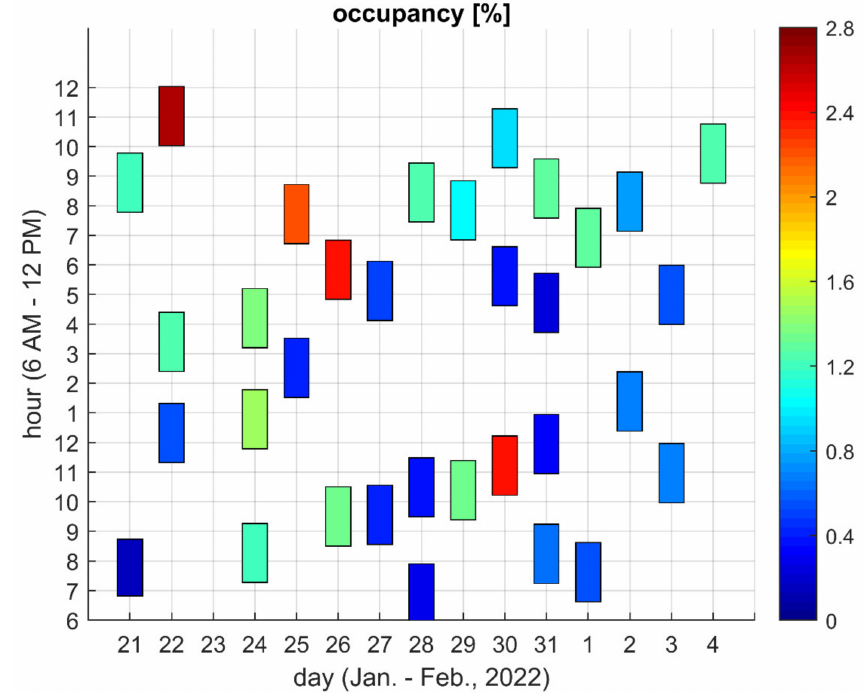
Figure 3. Channel occupancy for Location A.